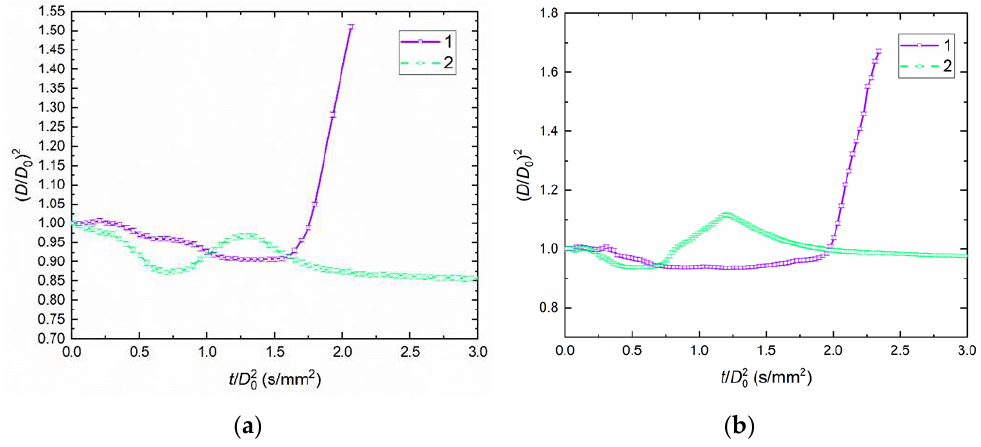
Figure 7. Temporal characteristics of droplet evaporation and drying until breakup for blends C50W49D1 ( a ) and C50W49R1 ( b ) ( R d0 = 1.3 ± 0.1 mm): 1 — T a = 450 ± 30 K; 2 — T a = 950 ± 30 K. C50W49D1 ( a ) and C50W49R1 ( b ) ( R ± 0.1 mm): 1— T a = 450 ± 30 K; 2— T a = 950 ± 30 d0 = 1.3